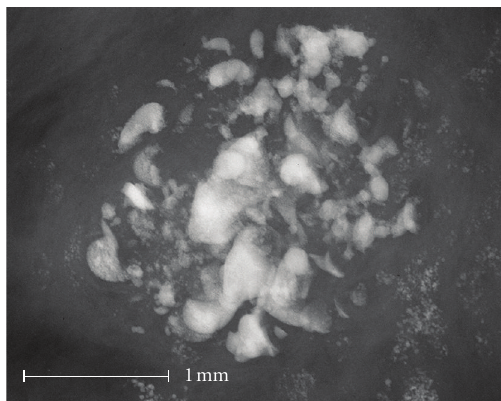
Figure 5: Fibrocystic mastopathy and adenosis. Microradiography demonstrates fine pleomorphic calcifications. This implies a malig- nant genesis as the cause of calcification. However, histology only detects adenosis in which the dilated ducts and acini are deformed that tracing of the irregular wall borders shows fine pleomorphic